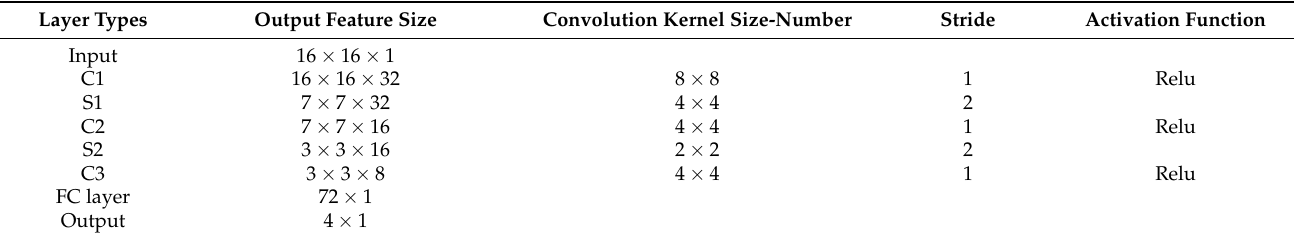
Table 1. Layer configurations of CNN